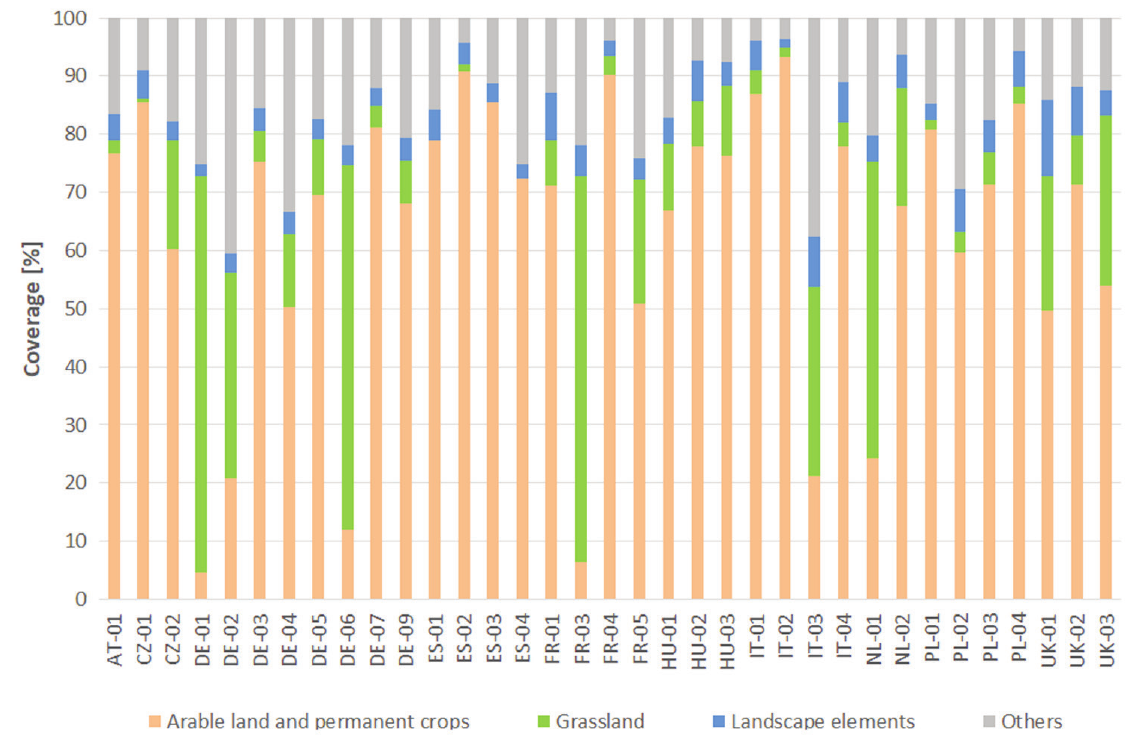
Figure 4. The coverage of main land cover types (%) in 35 studied EU farmland regions in 2014.